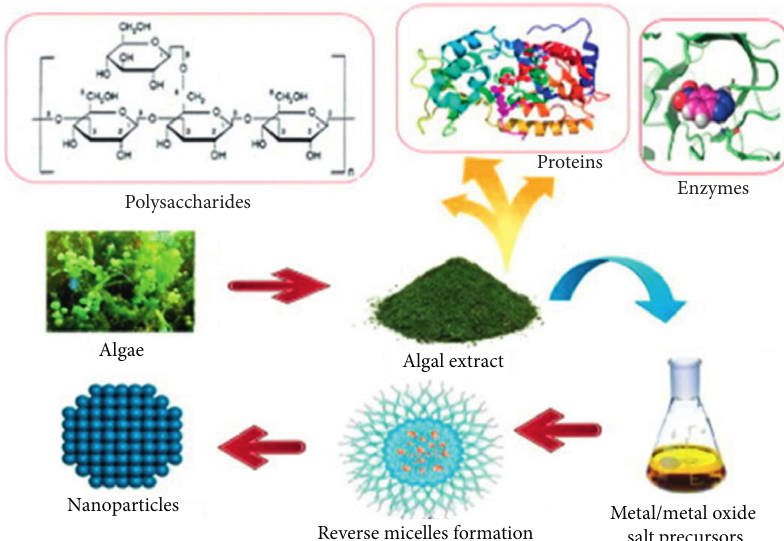
Figure 3: Algae-mediated synthesis of metal/metal oxide NPs